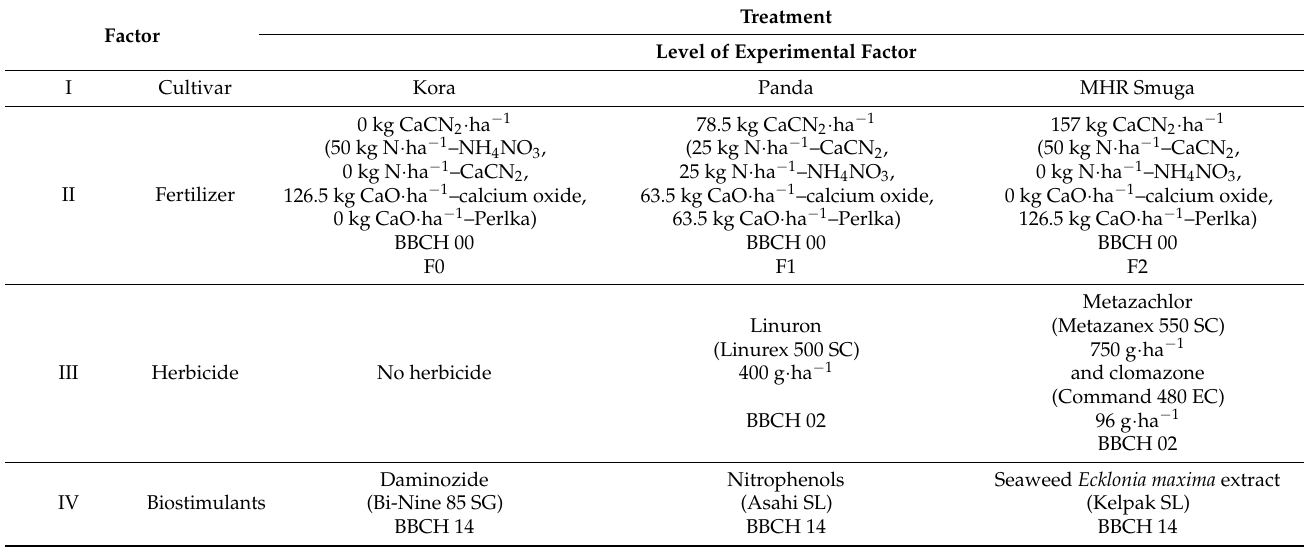
Table 1. Experimental factors and their